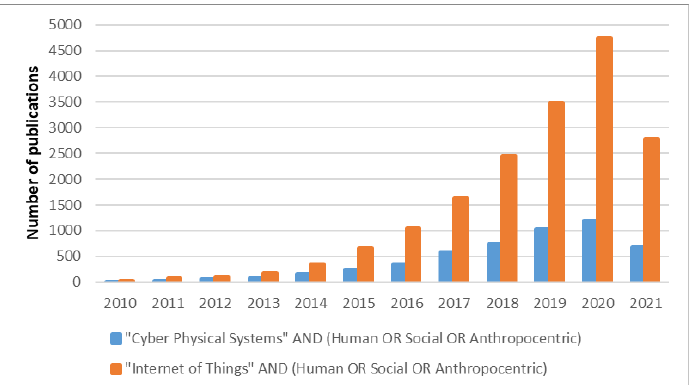
Figure 2. Results for the searches (S1) and (S2) in ScienceDirect scientific Database (April 2021).